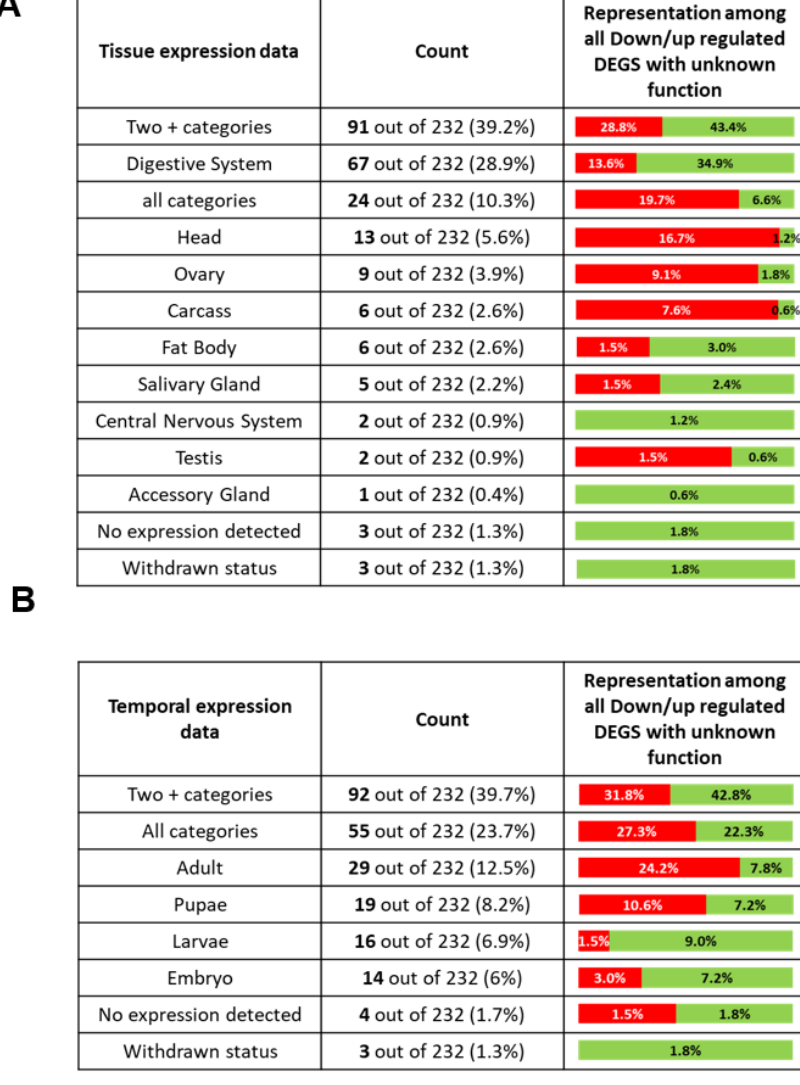
( A ) and ( B ) corresponds to the difference of repartition between downregulated and upregulated DEGs. The red percentage corresponds to the proportion of downregulated DEGs that belong to this category, whereas a green percentage corresponds to the proportion of upregulated DEGs. Asterisks after the name correspond to the result of a two-tailed Fisher exact test. no asterisk: non-significant. ( A ) Expression of all DEGs with unknown function in different tissues. ( B ) Expression of all DEGs with unknown function during different developmental